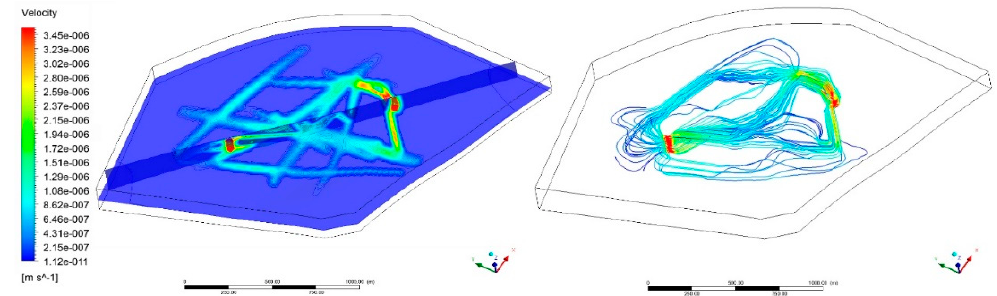
Figure 9. Velocity (superficial velocity) distribution and streamlines in reservoir.